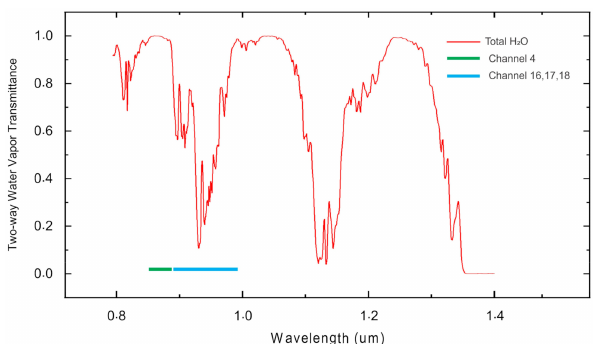
Figure 2. Total atmospheric water vapor transmittance for a spectral range of 0.8–1.4 µ m covering the FY-3D MERSI-2 NIR bands 4, 16, 17, and 18, respectively. The values were computed for a tropical atmosphere at downward looking geometry, the green line represents the position of non-absorption / window channel, and the blue line represents water vapor absorption channels as a function of